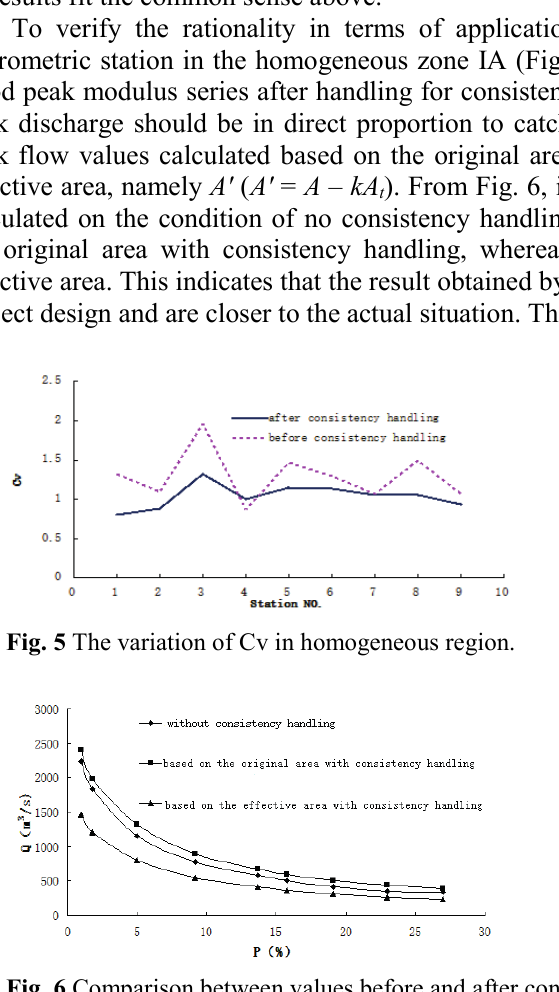
Fig. 6 Comparison between values before and after consistency